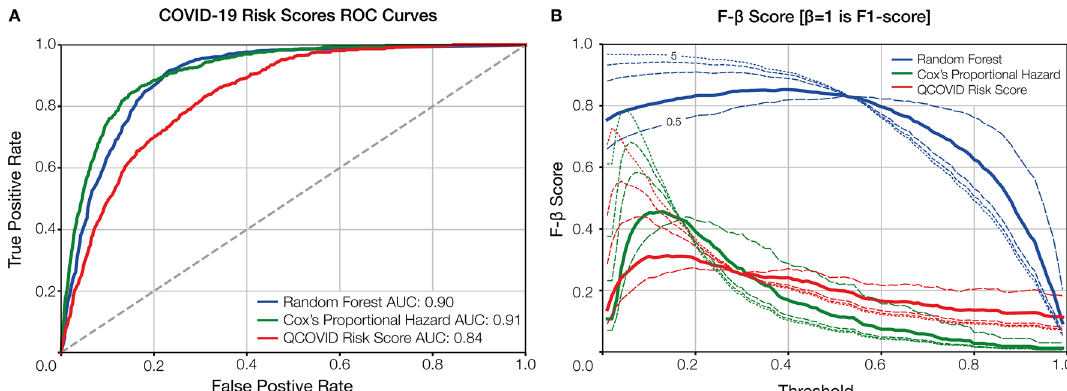
Figure 2. Model performance evaluation. ( A ) the receiver operating characteristic (ROC) curve comparison shown for our Random Forest (RF) and Cox models against QCOVID. ( B ) the F-β score generated at β = 1 (F1-score in bold), β = [ 0.5, 2, 3, 5], shown in decreasing size dashed line. AUC = area under the curve. Both the ROC and F-β score curves show the performance at various thresholds (i.e. operation points). Threshold value may be dependent on the application of the model. For example, in clinical circumstances requiring low false negatives, the threshold would be optimised for recall, though this would also correspond to higher numbers of false positives.